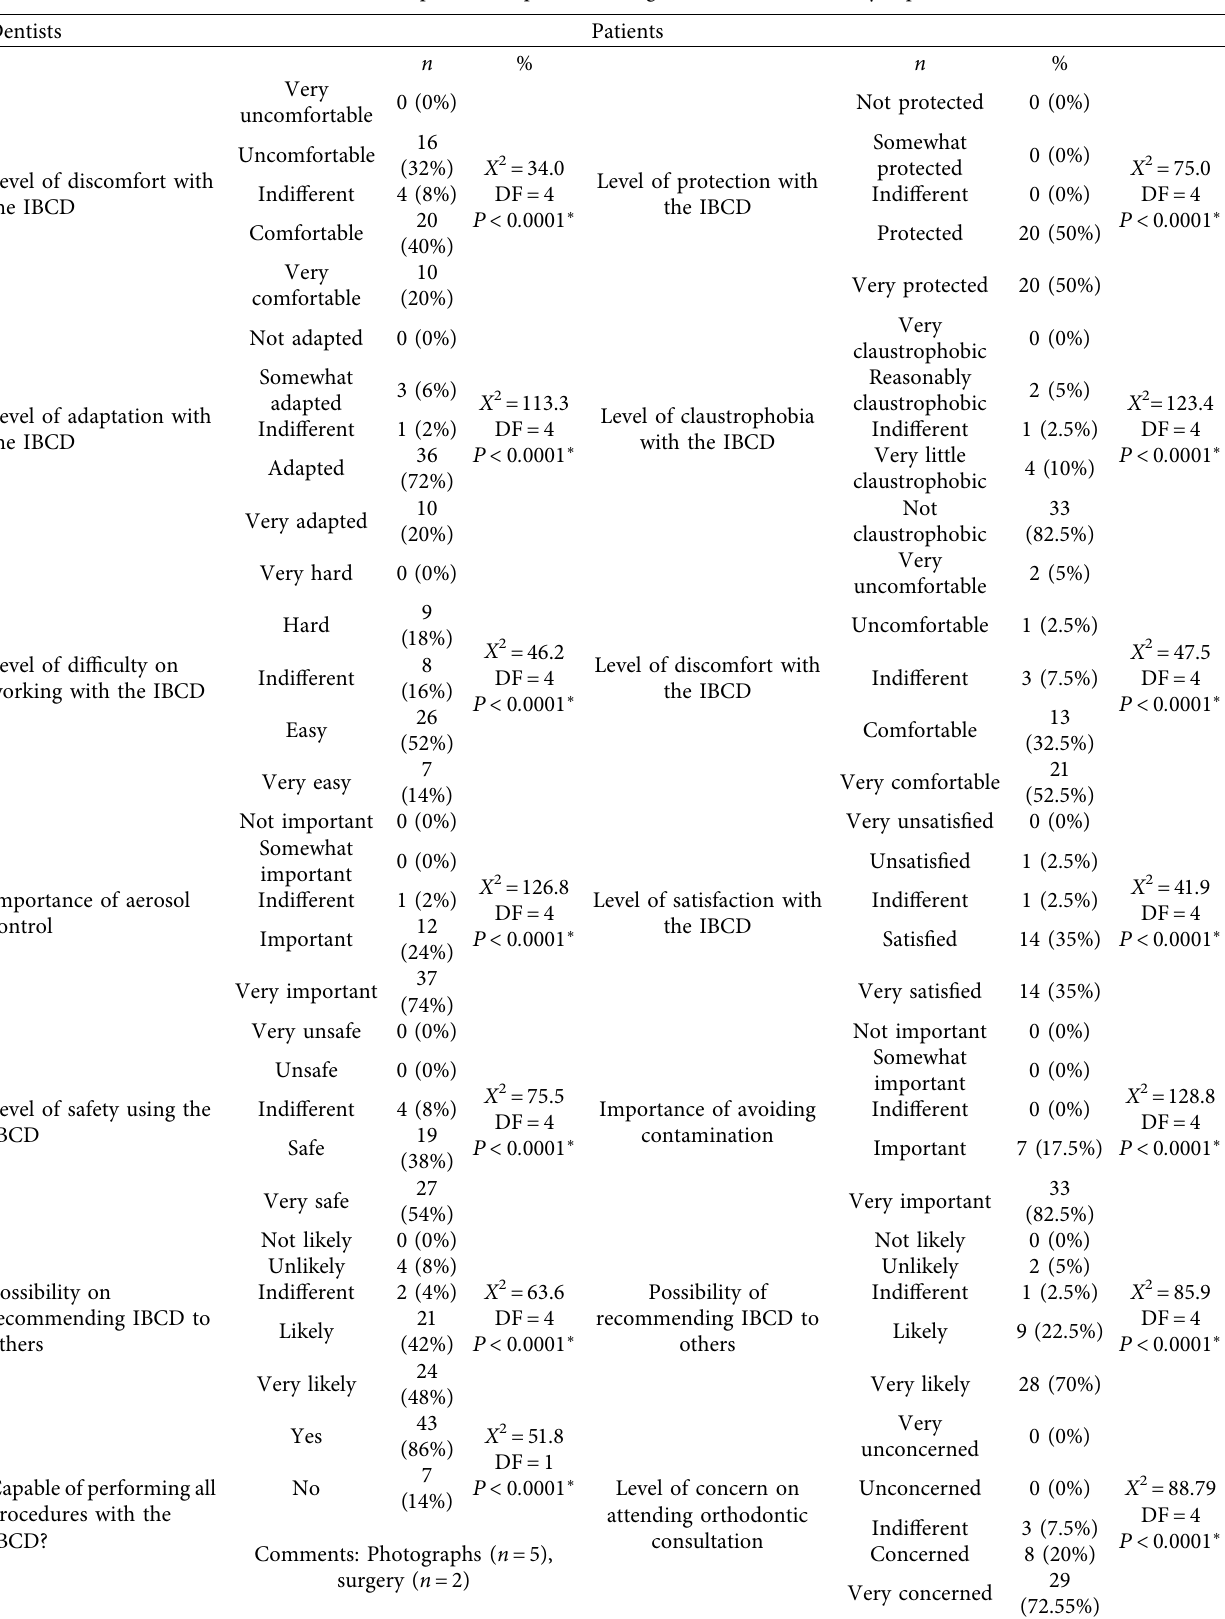
Table 2: Results of dentists’ and patients’ experience using the individual biosafety capsule device (IBCD).